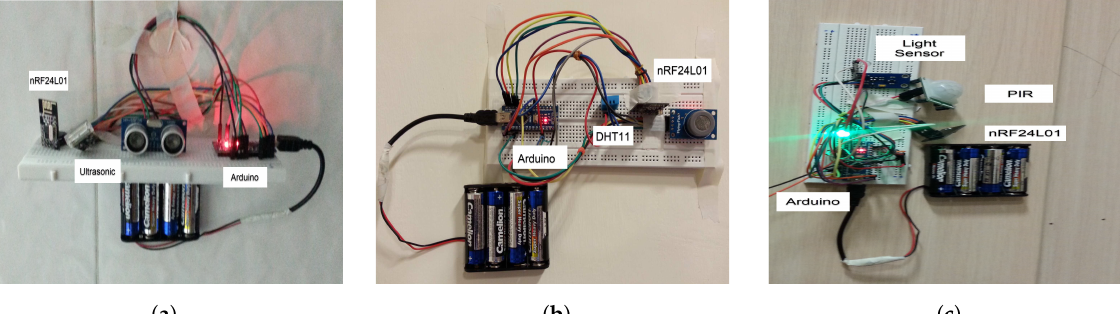
Figure 2. Illustration of different sensors in our smart home application: ( a ) Ultrasonic sensor, nRF24L01 transceiver, and Arduino board, ( b ) temperature and humidity sensor, nRF24L01 transceiver, and Arduino board, and ( c ) motion sensor, light sensor, nRF24L01 module, and Arduino board.